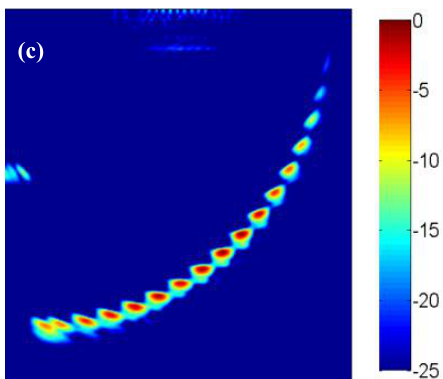
Figure 8. The sparse total focus imaging ( a ) No interpolation; ( b ) Bilinear interpolation; ( c ) NEDI interpolation with 8-element.